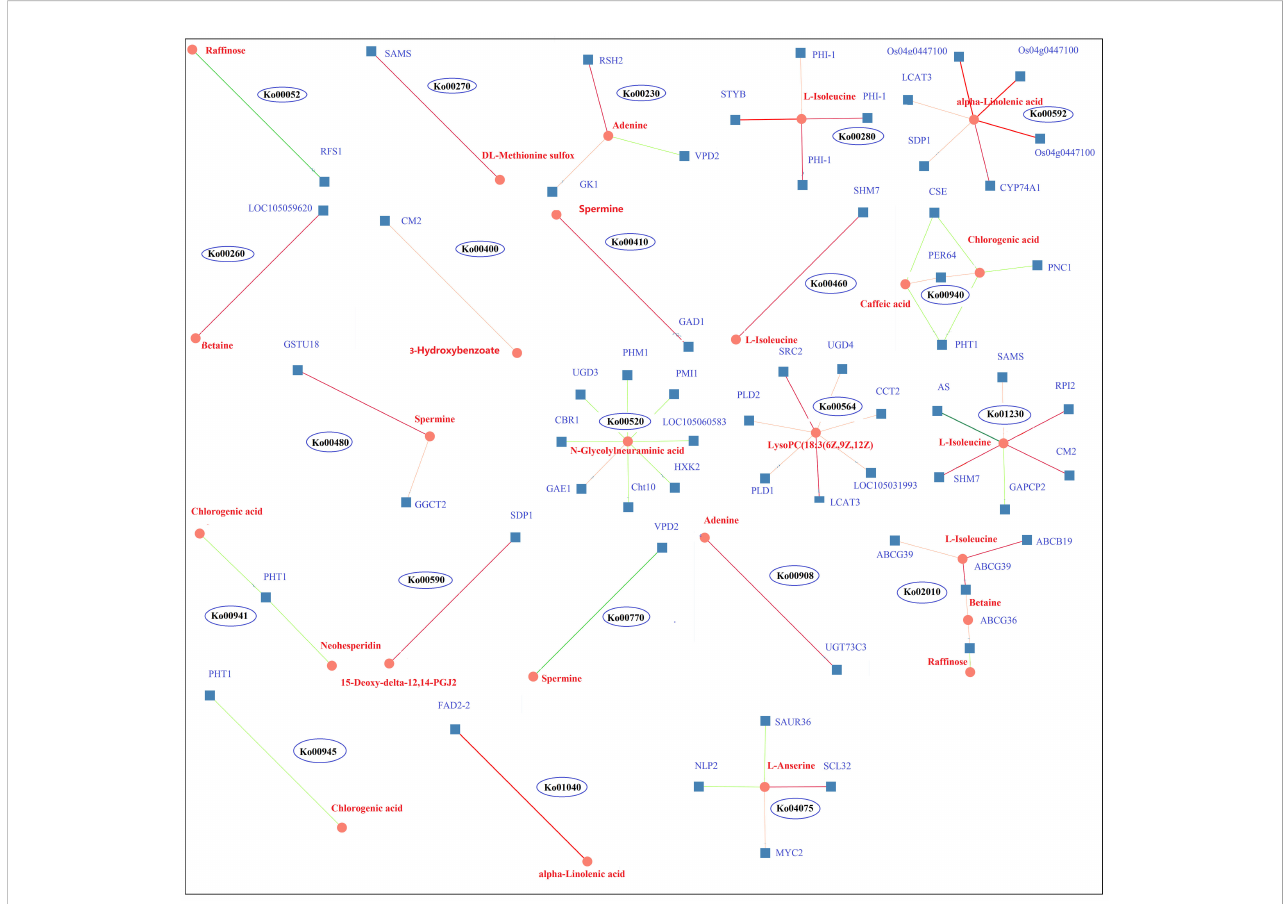
FIGURE 10 DEG and DAM correlation network diagram of 22 KEGG pathways in K 0 vs. K ck . Circles represent metabolites, boxes represent genes, and values on the line represent correlation coef fi cients. Positive and negative correlation is indicated in red and green, respectively. The larger the correlation coef fi cient, the wider the line and the darker the color. The number in each ellipse indicates the ID of the KEGG pathway corresponding to the network